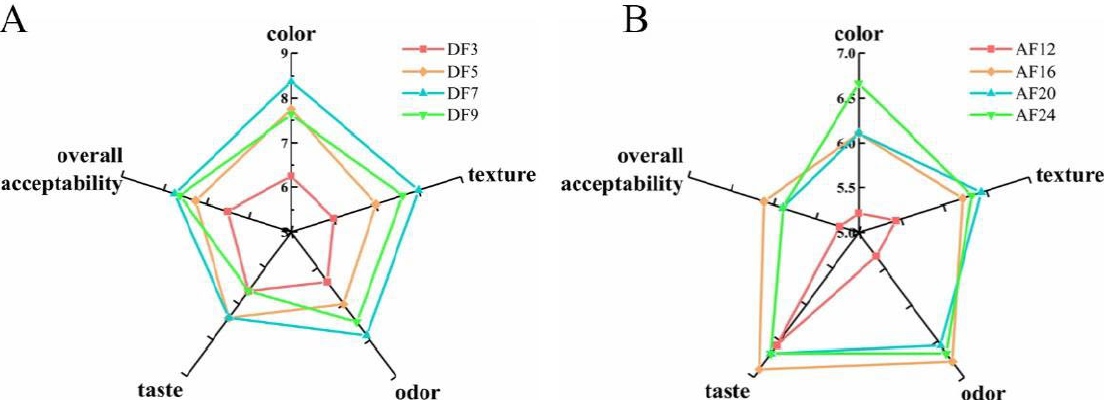
Figure 3. Radar chart of sensory scores for different fried hairtail fillets. ( A ) Radar chart of sensory scores of deep frying. ( B ) Radar chart of sensory scores of air frying. DF3, deep frying for 3 min; DF5, deep frying for 5 min; DF7, deep frying for 7 min; DF9, deep frying for 9 min; AF12, air frying for 12 min; AF16, air frying for 16 min; AF20, air frying for 20 min; AF24, air frying for 24 min.